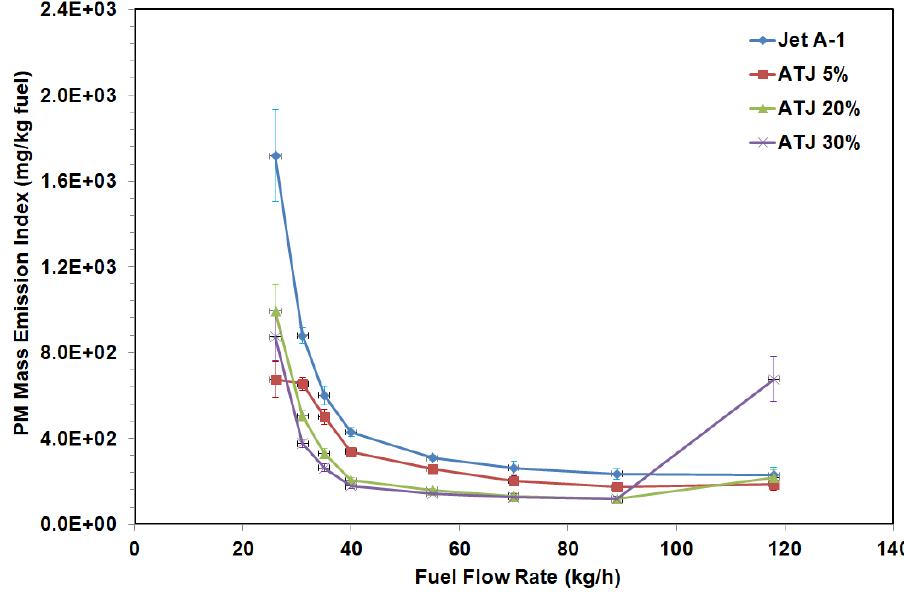
Figure 4. PM mass emission index (EI M ) versus DGEN 380 fuel flow. Error bars represent one standard deviation.